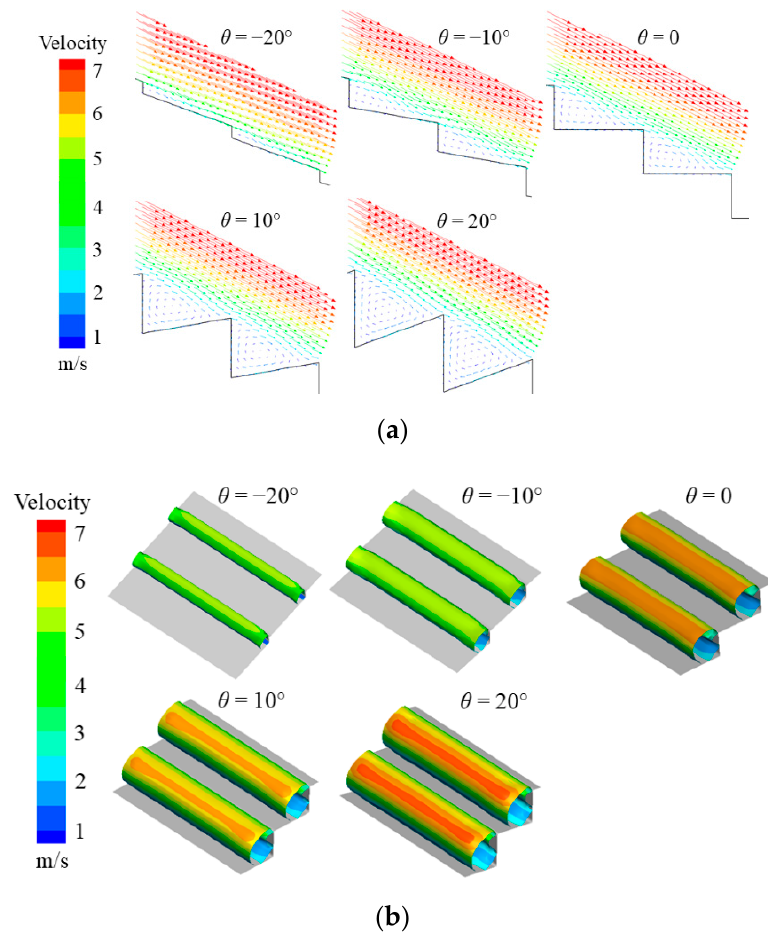
Figure 2. Flow fields at the steps at different θ values (for d c / h = 4.8 at steps no. 42 and 43): ( a ) velocity vectors, and ( b ) vortex structures ( Q c = 100).